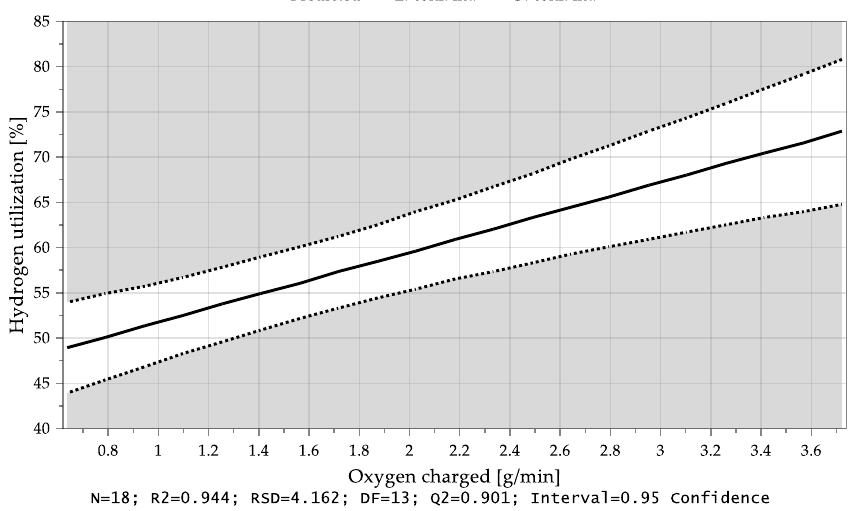
Figure 14. Average hydrogen utilization as a function of the charged oxygen rate.